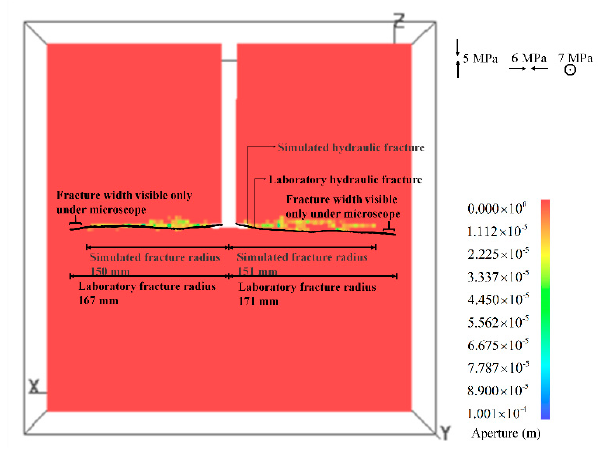
Figure 2. Injection pressure response and rate variations during fracturing (the laboratory pressure and injection rate curves are redrawn from [65]).